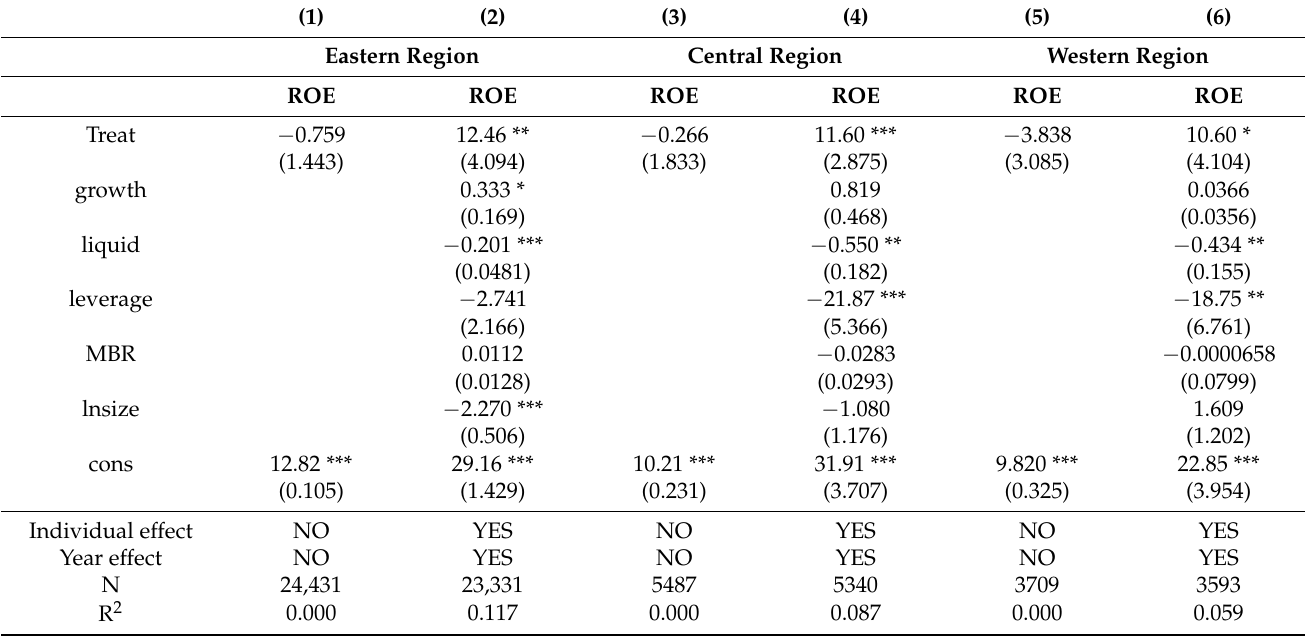
Table 9. Results of region